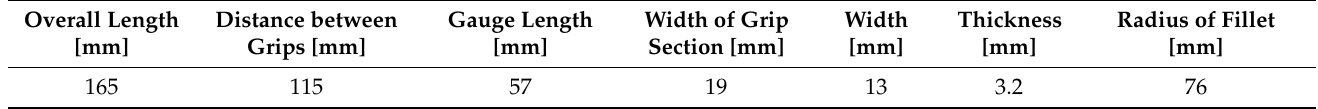
Table 2. The dimensions of specimens subjected to tensile testing.